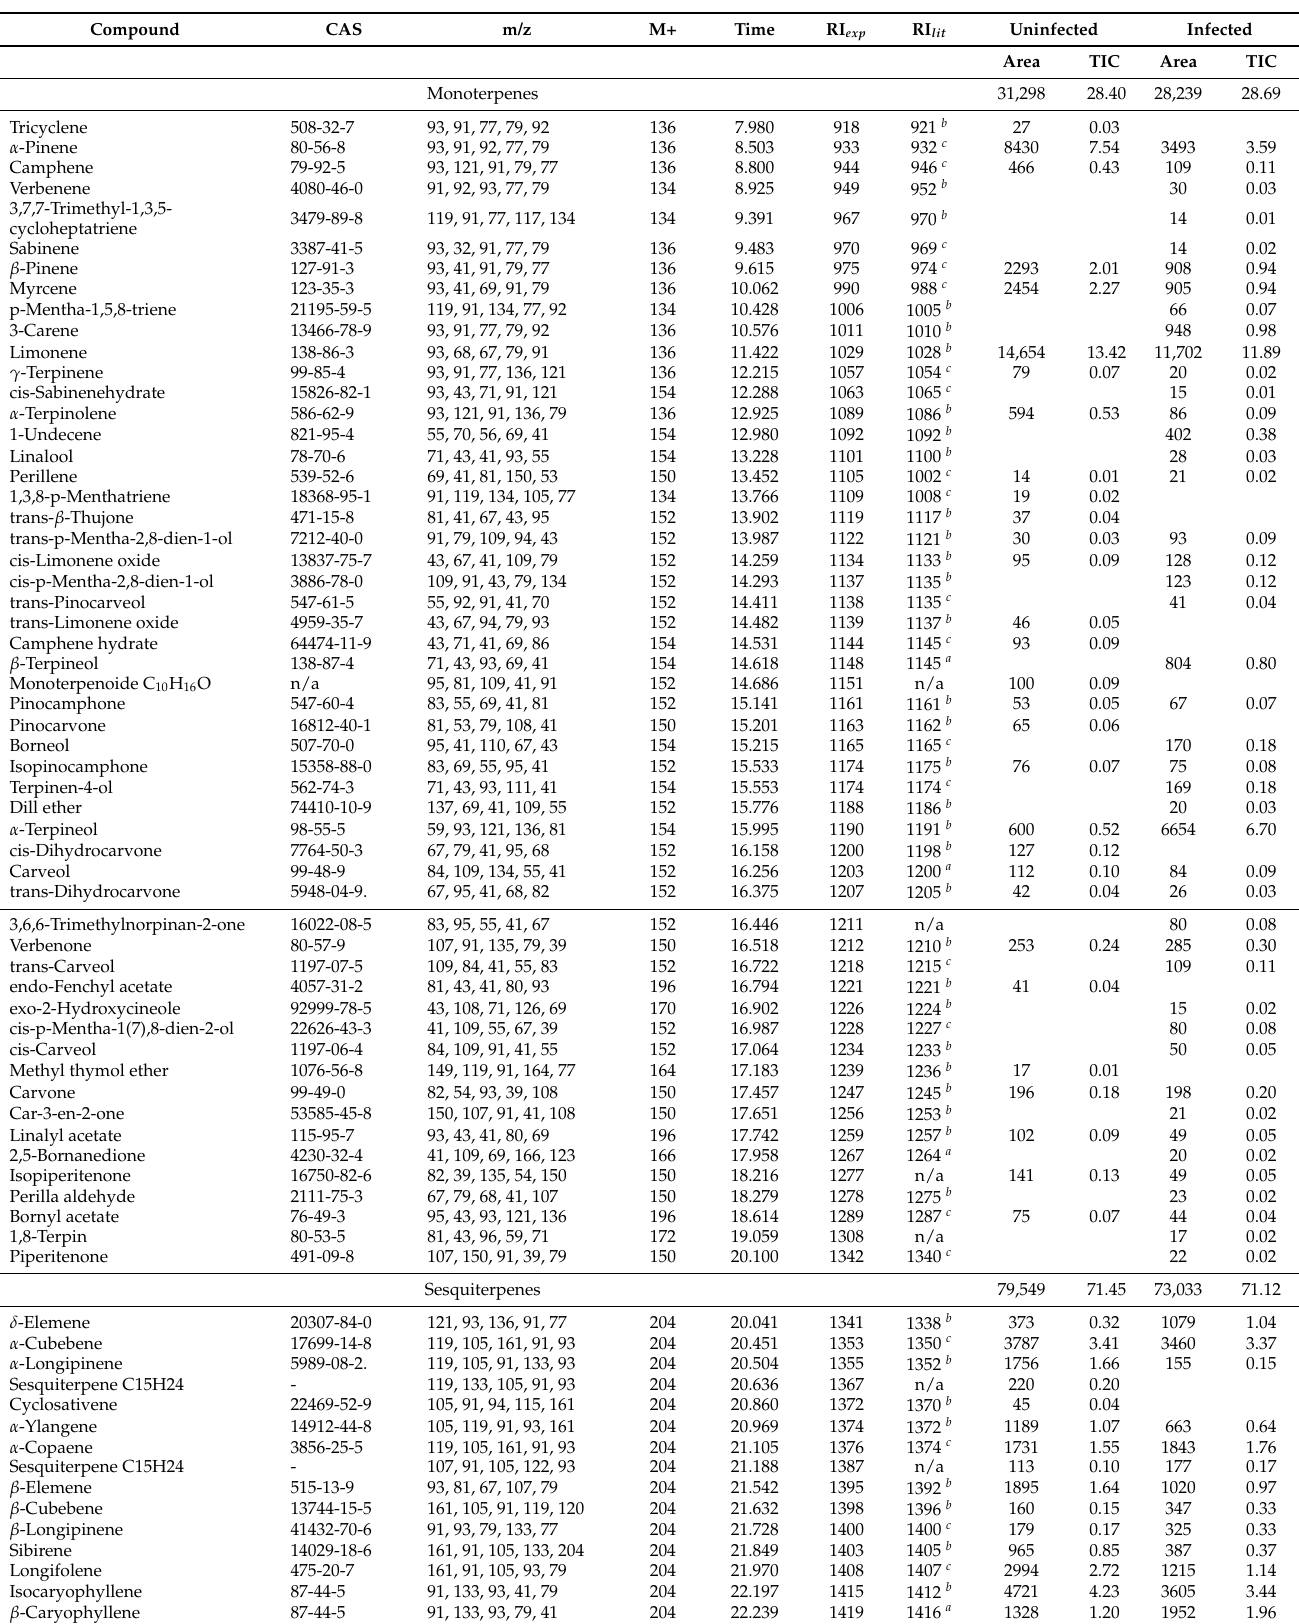
Table A5. The chemical components identified by the Gas Chromatography–Mass Spectrometry measurements. The meaning of columns is defined in Table